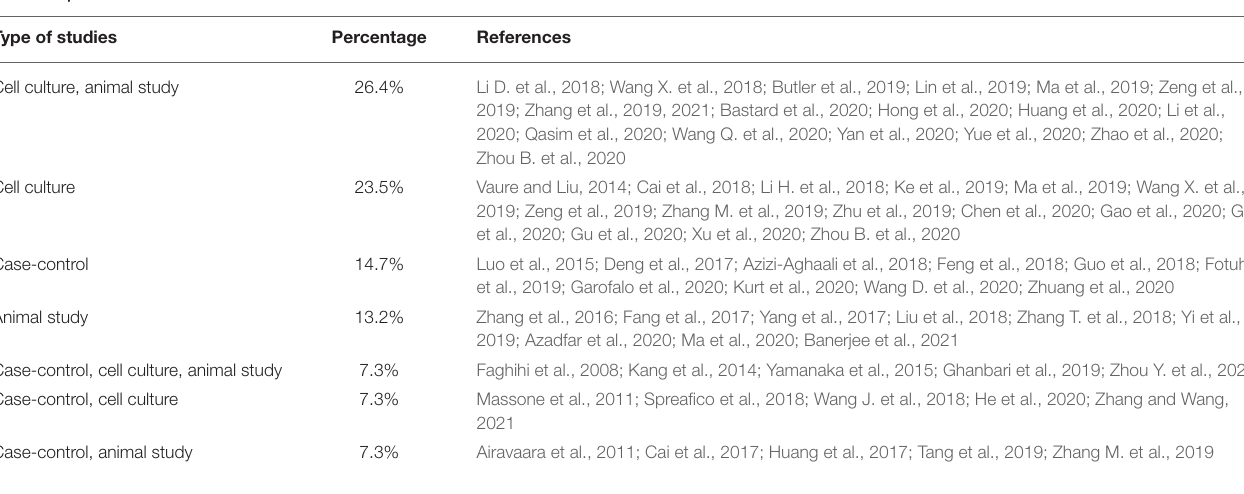
TABLE 2 | Articles